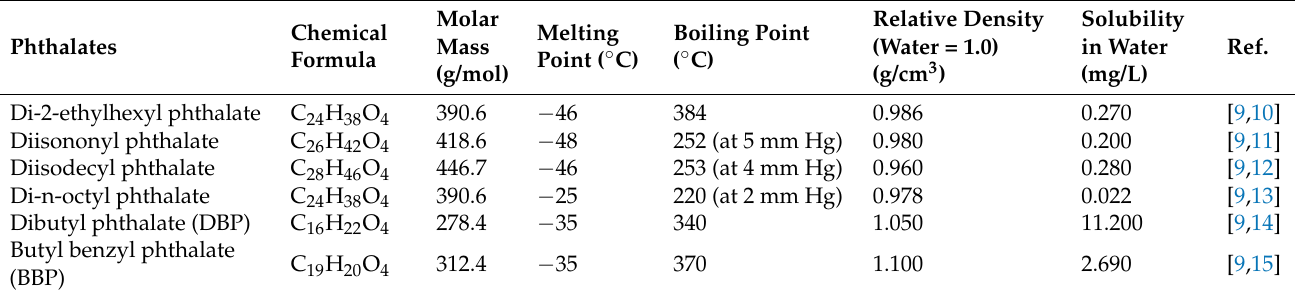
Table 1. Physicochemical properties of the six common